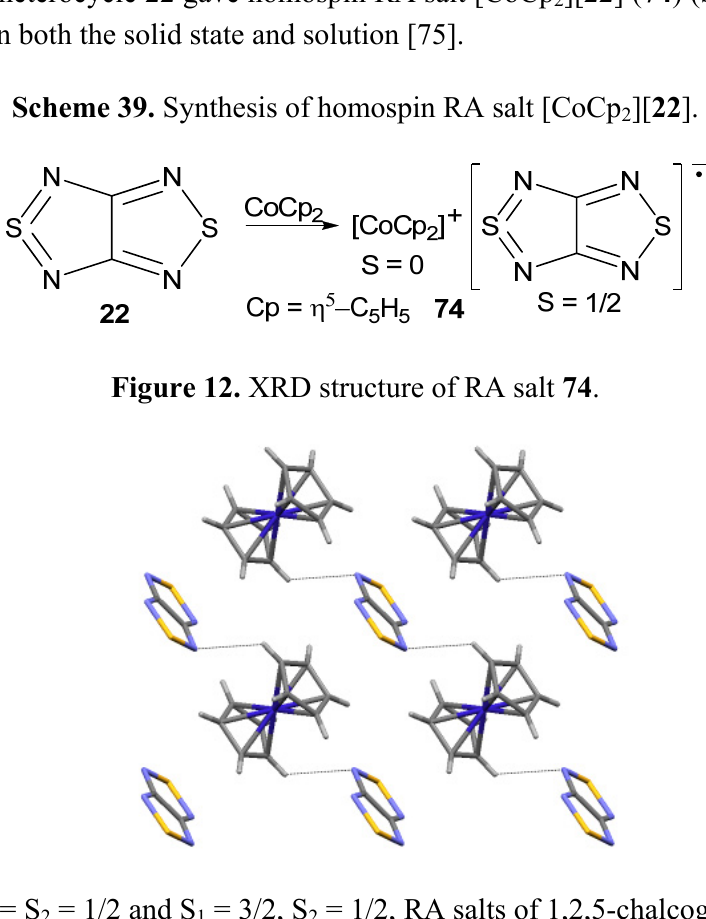
Figure 11. XRD structure of RA salt [TDAE][ 22 ]